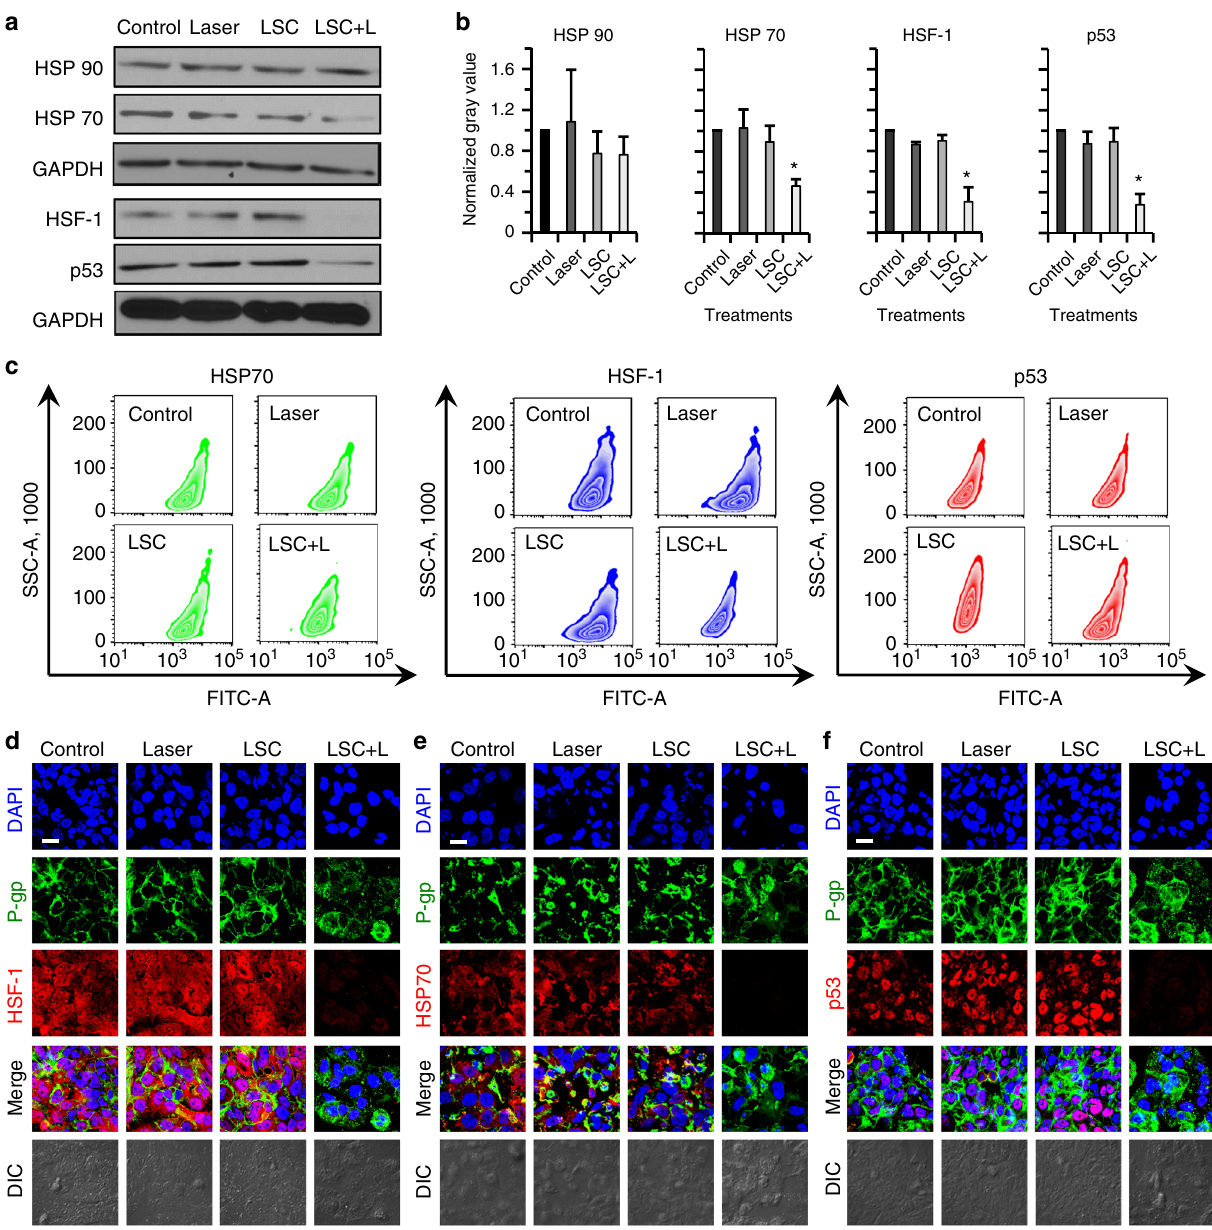
Fig. 8 Possible mechanisms of the LSC + L treatment in sensitizing the drug-resistant cells to cancer therapy. a Qualitative western blot data of heat shock protein 90 and 70 (HSP90 and HSP70), heat shock factor-1 (HSF-1), and mutant p53 proteins, showing decreased expression of HSP70, HSF-1, and mutant p53 after the treatment of LSC nanoparticles and NIR laser irradiation (LSC + L). b Quantitative data of the western blot results, showing the decreased expression of HSP70, HSF-1, and mutant p53 in the NCI/RES-ADR cells with the LSC + L treatment is statistically signi fi cant. Error bars represent s.d. ( n = 3). * p < 0.05 (Kruskal – Wallis H-test). c Flow cytometry analysis showing decreased expression of HSP70, HSF-1, and mutant p53 in NCI/RES-ADR cells treated with LSC nanoparticles and NIR laser irradiation. d Confocal images of HSF-1 showing the HSF-1 distributes in both nuclei and cytoplasm. e Confocal images of HSF70 showing the HSF70 mainly distributes in cytoplasm. f Confocal images of mutant p53 show the mutant p53 mainly distributes in nuclei. The distribution of P-gp is similar to that shown in Fig. 4a. No treatment (laser or nanoparticle) was conducted on the cells in the control group. The cells were permeabilized for the fl ow cytometry and confocal analyses. The NIR laser irradiation was at 1 W cm − 2 for 1 min. The concentration of LSC nanoparticles used for the LSC or LSC + L groups was 0.2 mg ml − 1 . Scale bars: 20 μ LSC-I nanoparticles, suggesting the tumor targeting capacity of LSC nanoparticles. In mice treated with LSC-I nanoparticles, the ICG fl uorescence in the tumor area further increases at 6 h. In contrast, no ICG fl uorescence is observable at 6 h in the tumor area of mice treated with either free ICG or SC-I nanoparticles. To con fi rm the whole-animal imaging data, various organs were harvested for ex vivo imaging after sacri fi cing the mice at 6 h.